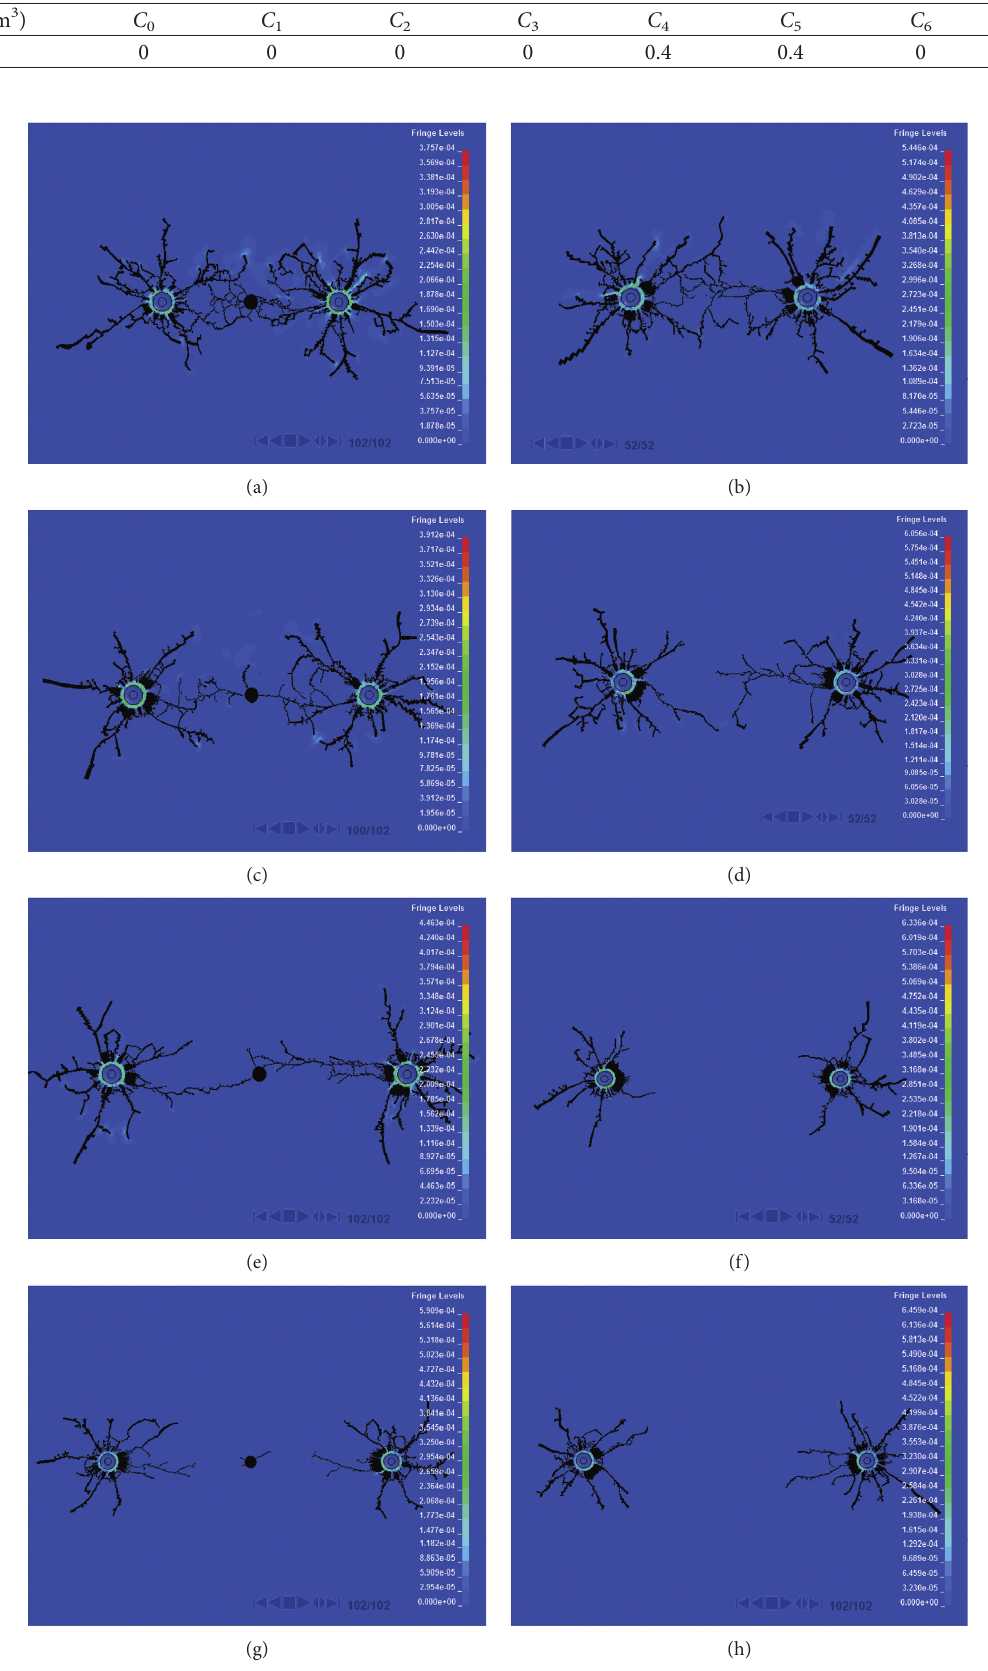
Figure 4: Crack distribution of different charge hole spacing. (a) 600mm. (b) 600mm. (c) 800 mm. (d) 800mm. (e) 1000mm. (f) 1000mm. (g) 1200mm. (h)